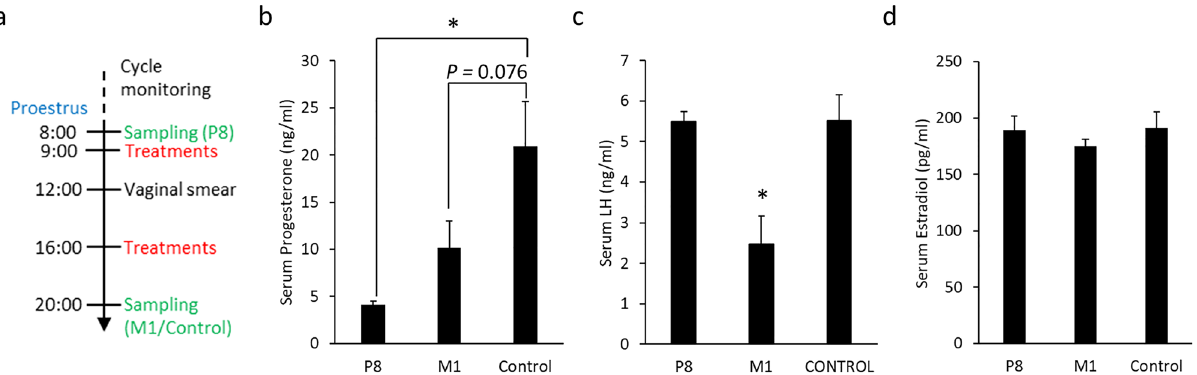
Figure 2. The impacts of M1 injection on the endocrine system. Eight-week-old ICR mice were treated with M1 at 9:00 and 16:00 on the day of proestrus, the blood samples were collected in the evening (20:00, a ). The concentrations of serum progesterone ( b ), LH ( c ), and estradiol ( d ) were measured. Values are mean ± SEM (n = 4–7). *Statistical significance by Student’s t-test, P <